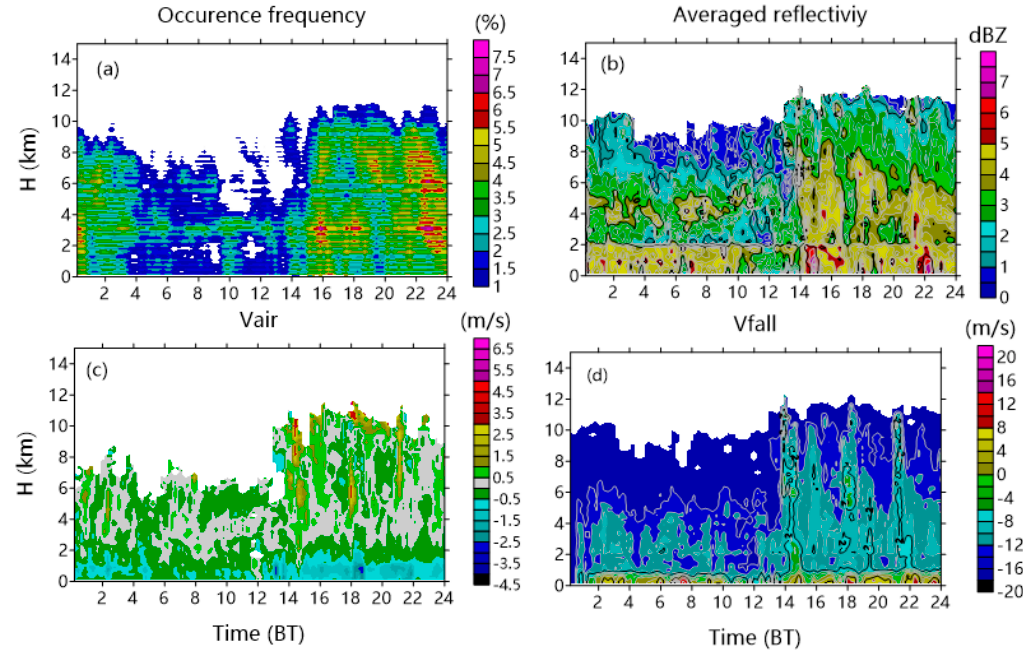
Figure 9. Diurnal variations in the averaged ( a ) occurrence frequency of the valid merged reflectivity, ( b ) reflectivity, ( c ) Vair, and ( d ) Vfall at various altitudes during July 2014.